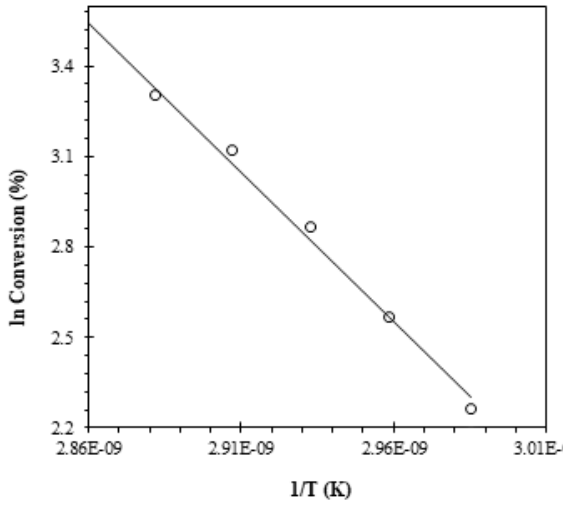
Figure 7. Activation energy calculated from Arrhenius plot for oxidation of CH. Conditions: Cat: 0.15 g, vol: 20 mL, pO 2 : 570 Torr, time: 210 min, temp: 60 − 80 °C, flow rate: 40 mL/min.